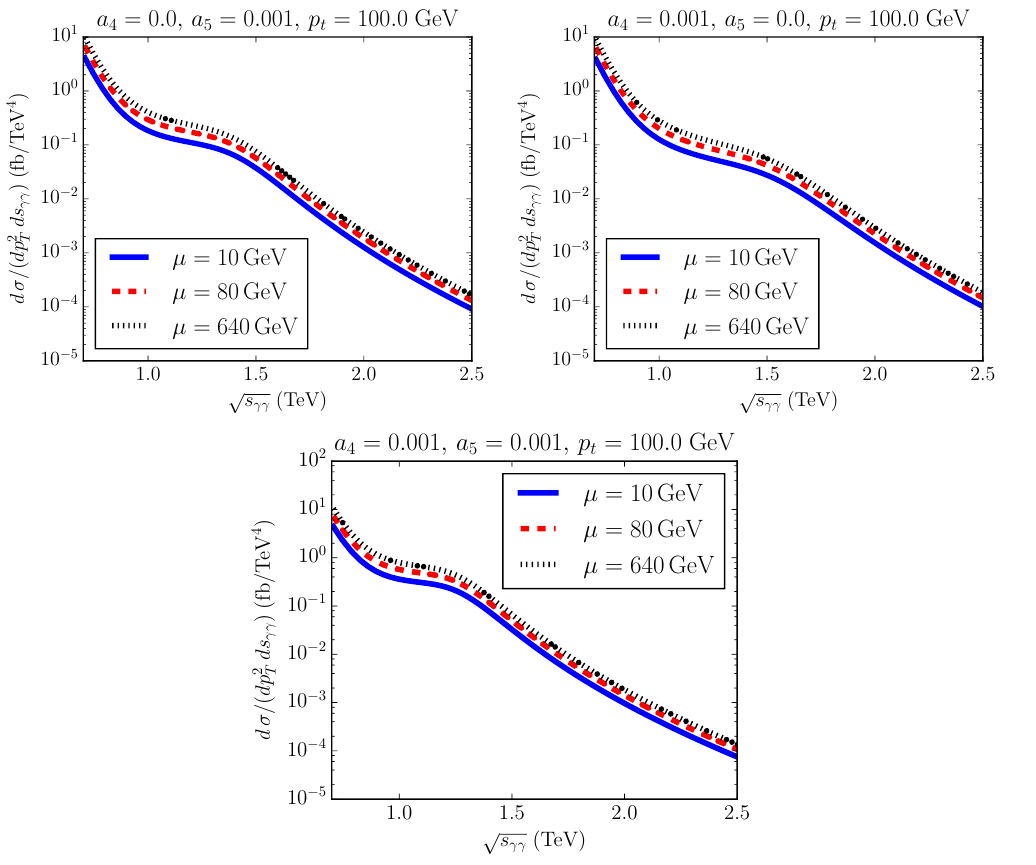
Figure 12 . Cross section for pp (cid:13)(cid:13)p (cid:3) p (cid:3) W L W L + X for three values of (cid:22) (the scale at ! ! which the LUX [69] photon (cid:13)ux factor is evaluated), di(cid:11)erential respect to the produced s W and the squared transverse momentum. The NLO parameters, visible in the plots, are chosen so that a resonance in the EWSBS amplitudes is present around 1.2{1.5 TeV. After convolution with the photon (cid:13)ux, only a broad shoulder is